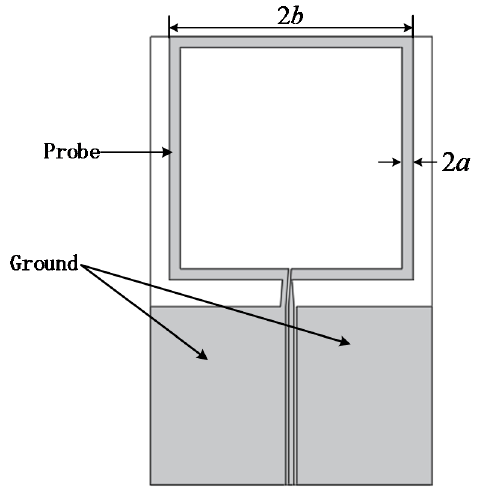
Figure 7. Schematic diagram of magnetic field probe structure.